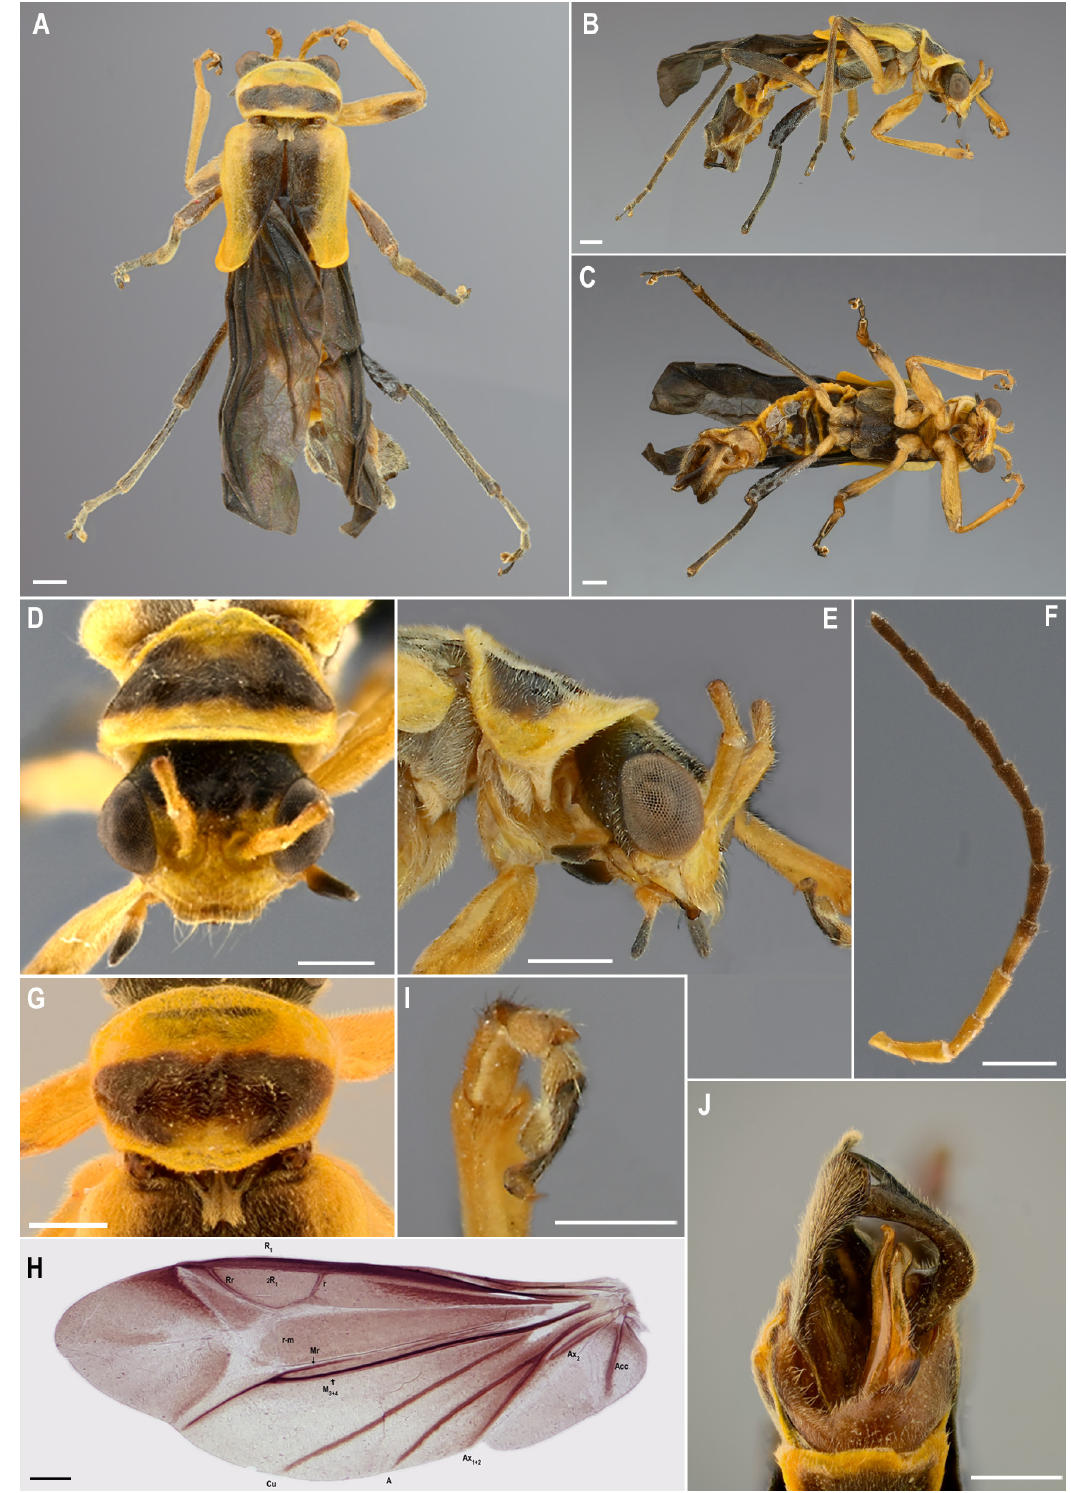
Fig. 2. Trypheridium kashmiricum sp. nov. ♂, holotype (KUIC 0013). A . Habitus, dorsal view. B . Habitus, lateral view. C . Habitus, ventral view. D . Head, frontal view. E . Head, lateral view. F . Antenna. G . Pronotum. H . Hind wing. I . Apex of fore tibia showing a pair of tiny spurs. J . Terminal segments, ventral view. Scale bars: 0.5